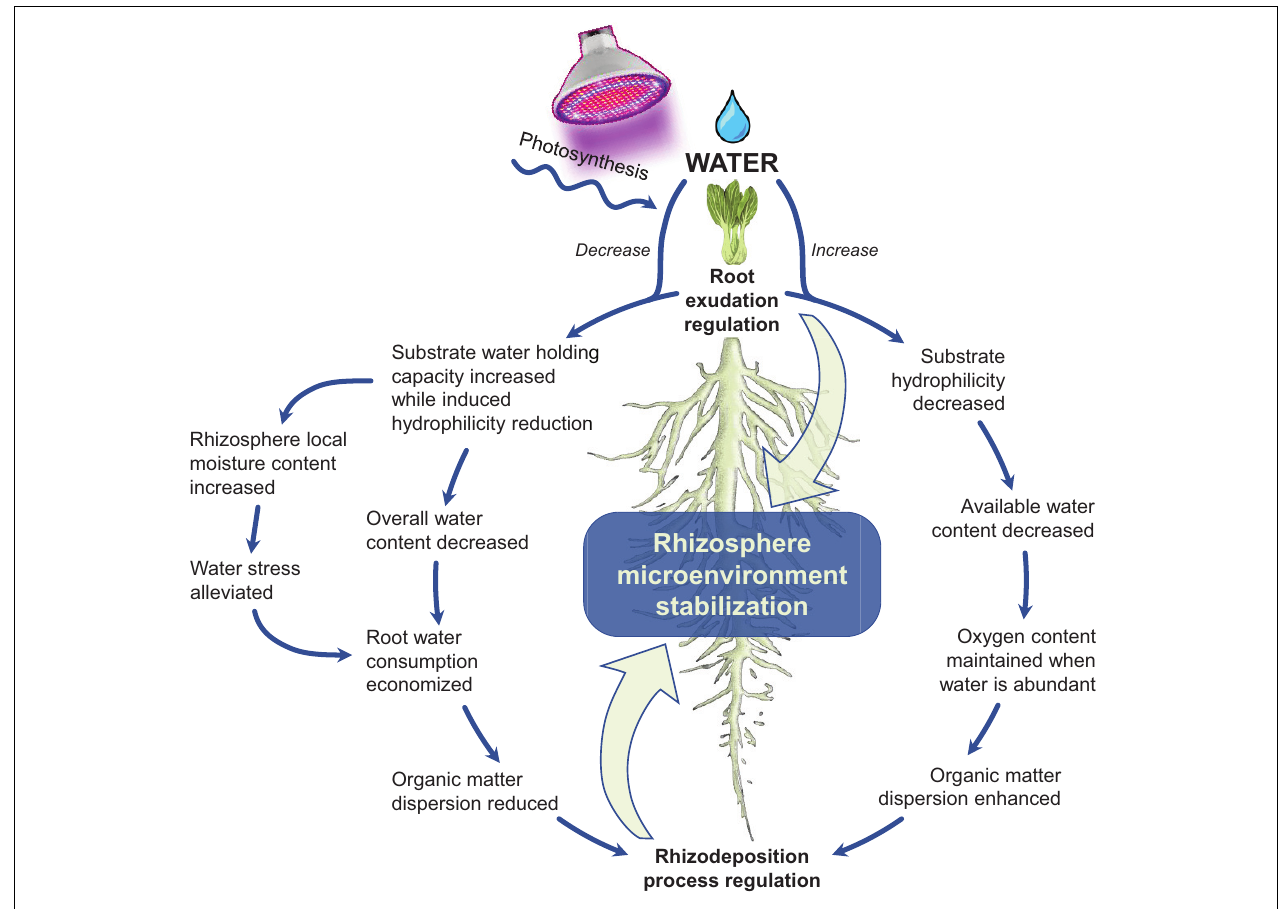
FIGURE 4 | A mechanism of rhizosphere microenvironment stabilization under water content variation (drawn by the authors).